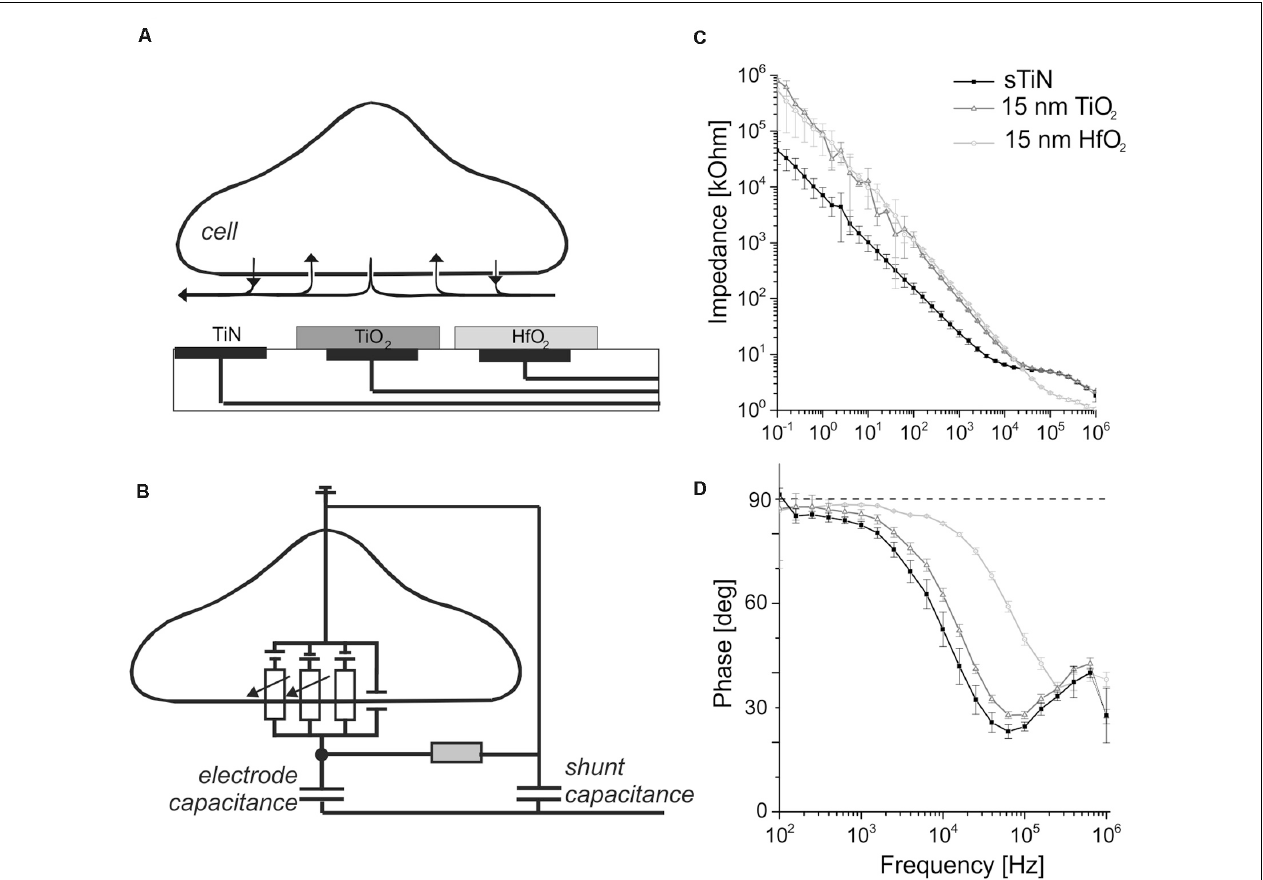
FIGURE 1 | Schematic of the capacitive electrodes used for neural sensing with their impedance and phase behavior. (A) A simplified schematic cross section of the utilized capacitive microelectrode array in contact with an electrogenic cell. Electrodes insulated with ALD-TiO 2 or ALD-HfO 2 are compared here with bare, compact TiN electrodes. (B) Schematic cross section showing a simplified equivalent circuit of an interfaced electrogenic cell, a capacitive sensing electrode, seal resistance, and shunt capacitance. Figure modified from rf. (Zeck et al., 2017). (C) Impedance measurement of the capacitive electrode with 15 nm TiO 2 (dark gray symbols) and 15 nm HfO 2 (light gray) and for the uncovered smooth TiN base electrode for comparison (black trace). (D) Phase angle of TiN stimulation electrode covered with 15 nm of HfO 2 (light gray) or TiO 2 (dark gray). Black symbols denote the phase shift for bare smooth TiN.